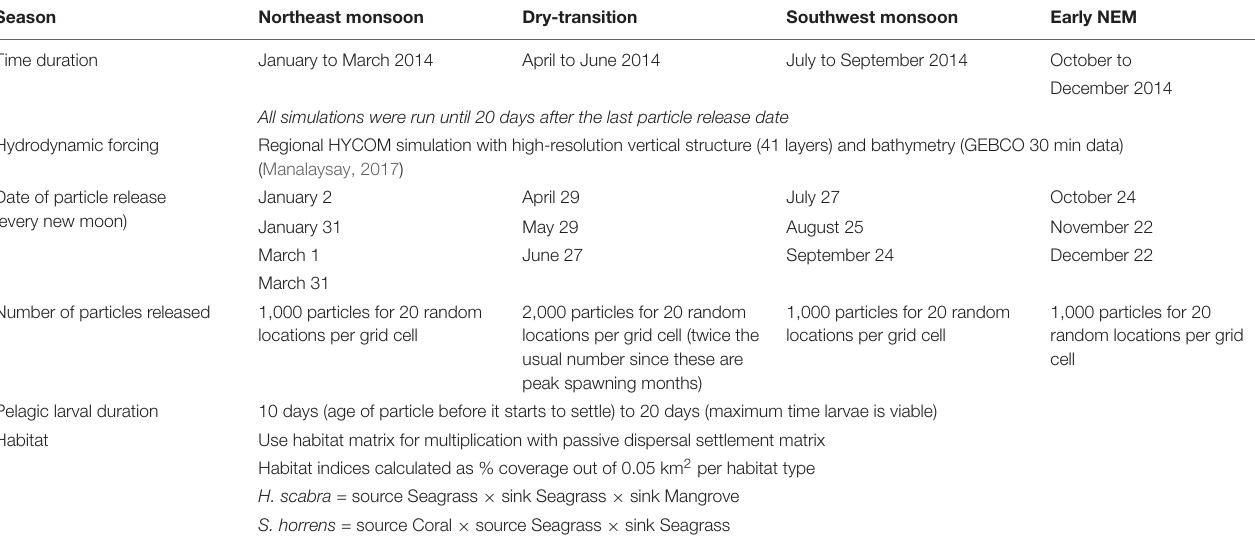
TABLE 1 | Summary of parameters used for the biophysical model.